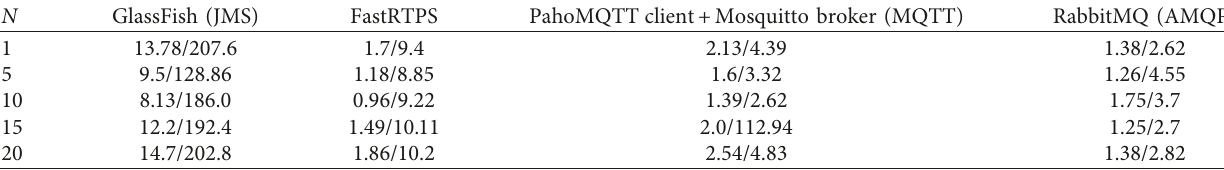
Table 2: Mean and maximum delay with different subscriber